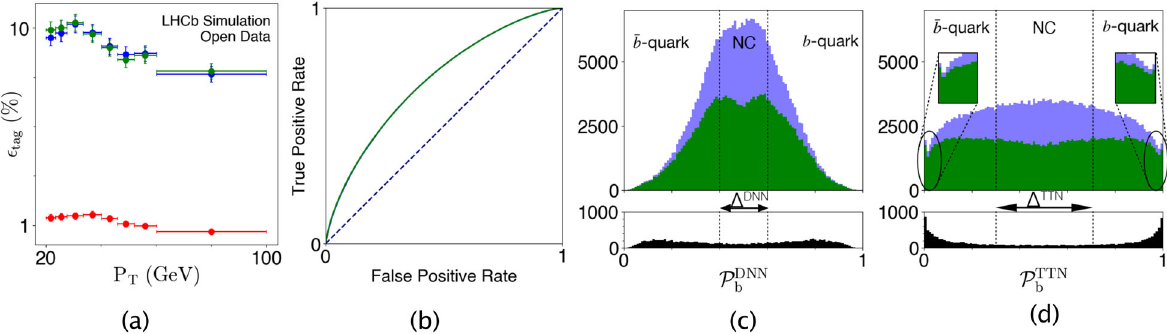
Fig. 2 Comparison of the DNN and TNN analysis. a Tagging power for the DNN (green), TTN (blue) and the muon tagging (red), ( b ) ROC curves for the DNN (green) and the TTN (blue, but completely covered by DNN), compared with the line of no-discrimination (dotted navy-blue line), ( c ) probability distribution for the DNN and ( d ) for the TTN. In the two distributions ( c , d ), the correctly classi fi ed events (green) are shown in the total distribution (light blue). Below, in black all samples where a muon was detected in the jet.